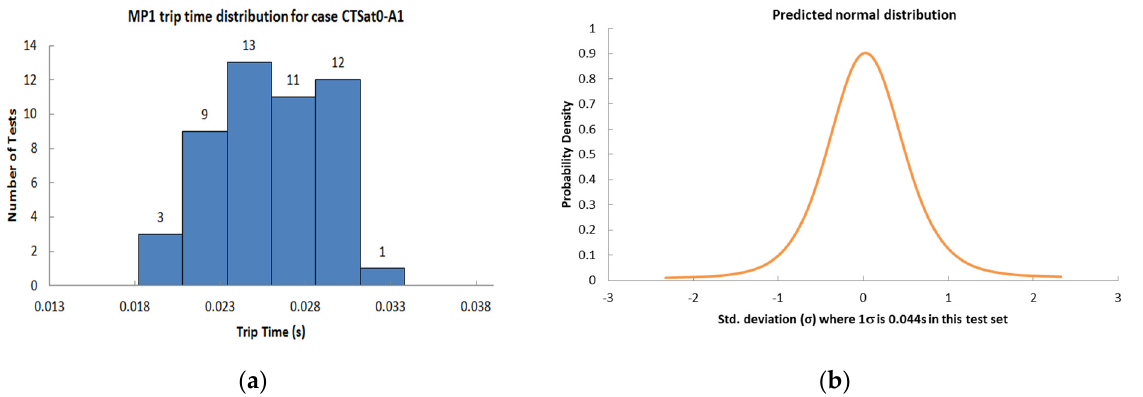
Figure 9. MP1 trip time distributions and predicted MP1 trip time as a normal distribution for case CTSat0-A1 (no CT Sat, no faulty component, 3Ph-G faults at 50% of the feeder).